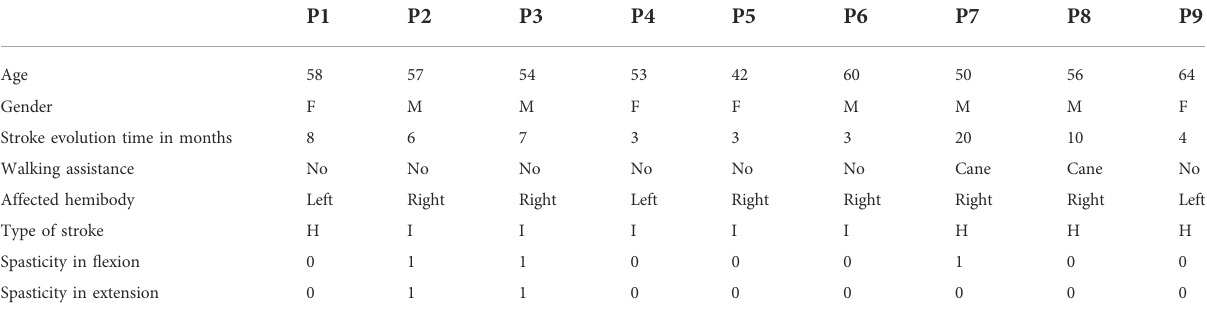
TABLE 2 Clinical and demographic characteristics of